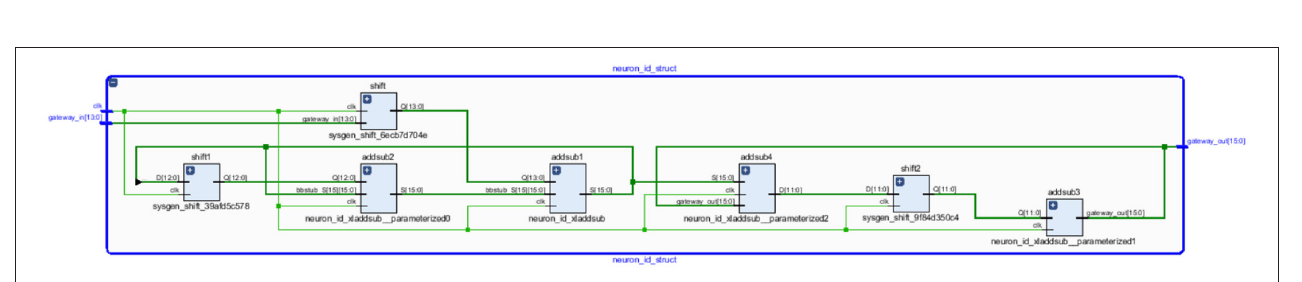
FIGURE 10 | RTL Schematic—Neuron